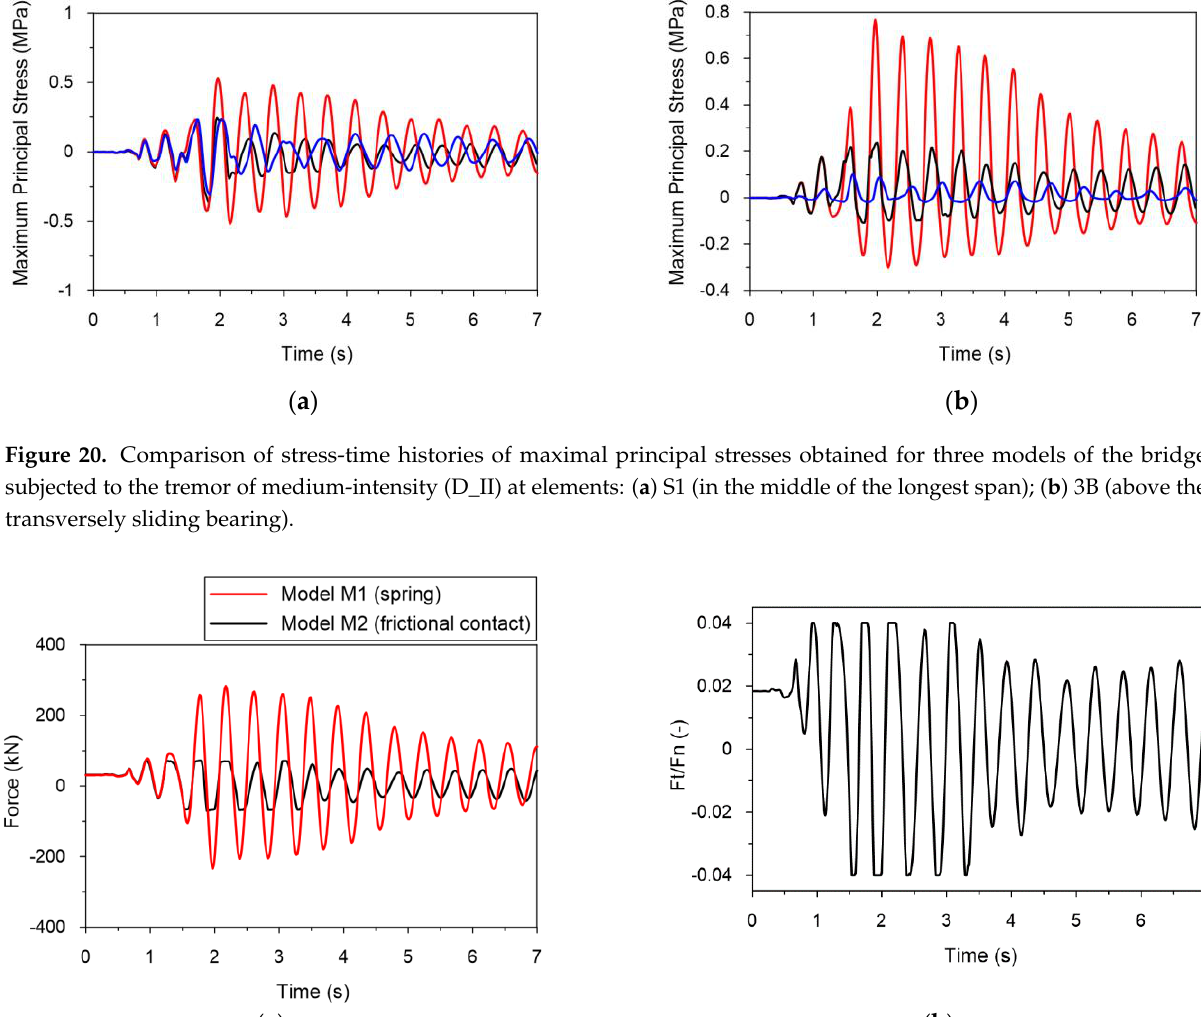
Figure 20. Comparison of stress-time histories of maximal principal stresses obtained for three models of the bridge sub- jected to the tremor of medium-intensity (D_II) at elements: ( a ) S1 (in the middle of the longest span); ( b ) 3B (above the transversely sliding bearing).